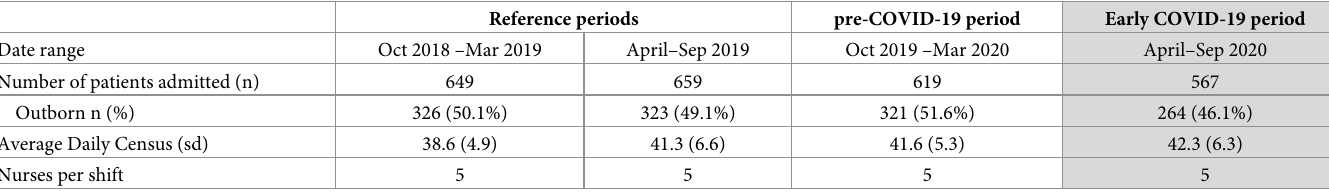
Table 1. Admissions per period, unit census and staffing